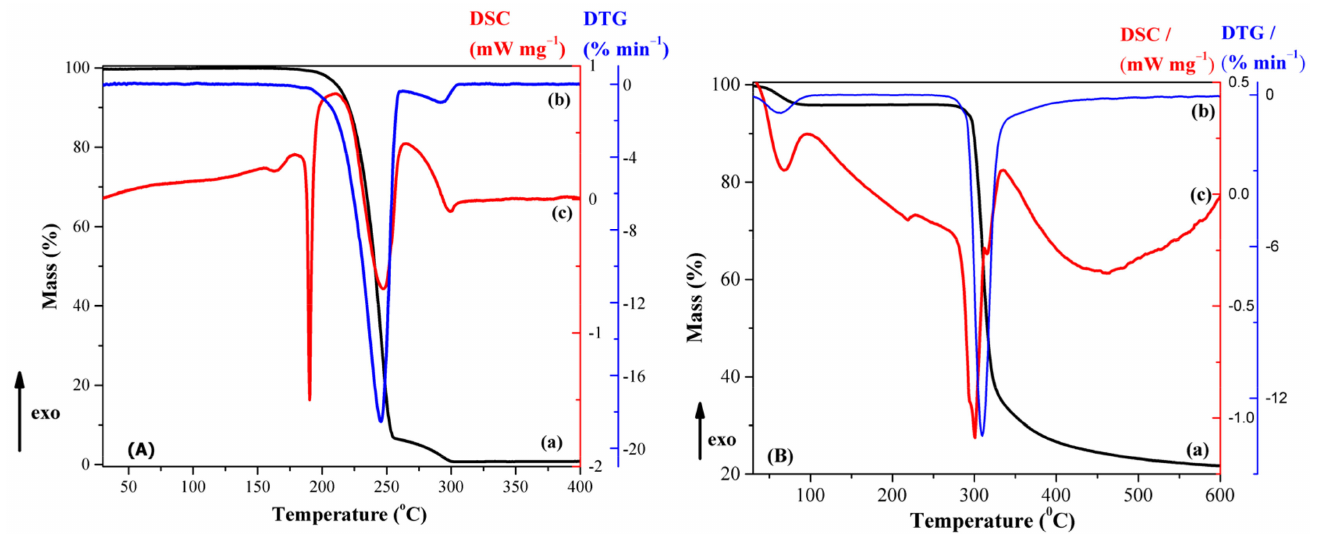
Figure 4. Thermal curves of ( A ) CBZ and ( B ) β -CD, with (a) TG, (b) DTG and (c) DSC (dynamic argon atmosphere, β = 5 ◦ C min − 1